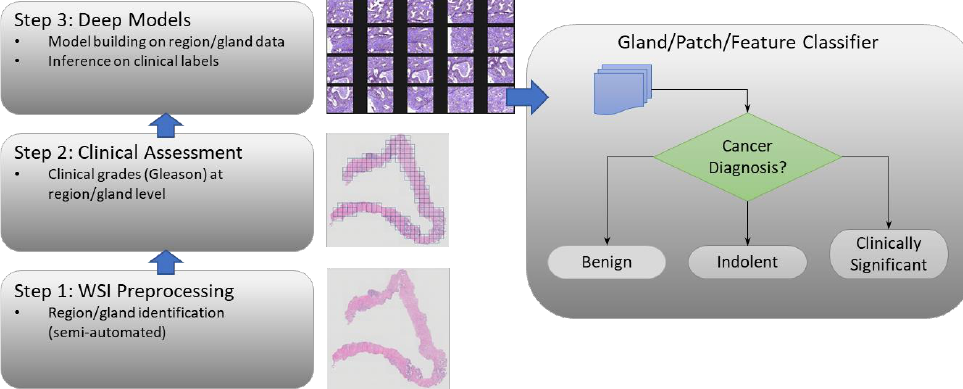
Figure 1. Prostate Cancer Decision Support System.